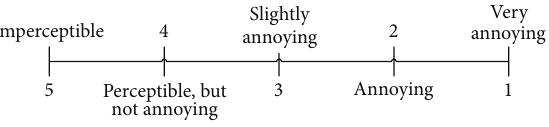
Figure 3: Subjective test